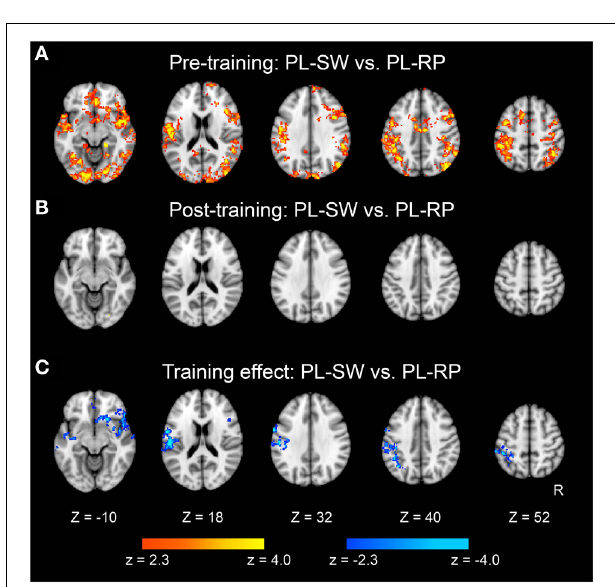
FIGURE 7 | Statistical significance maps for searchlight MVPA for Plain-Switch vs. Plain-Repeat trials ( P < 0 . 05 cluster size corrected). (A) Pre-training session. (B) Post-training session. (C) The difference in classification accuracy between pre- and post-training session. The formats are similar to those in Figures 5 , 6 .